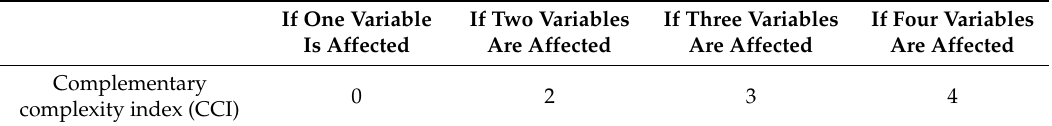
Table 4. Complementary complexity